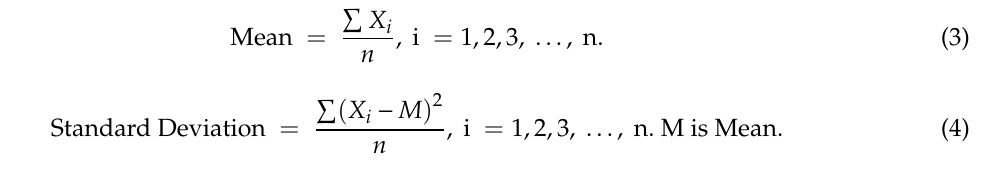
Table 5. Descriptive statistics and correlation analysis of major